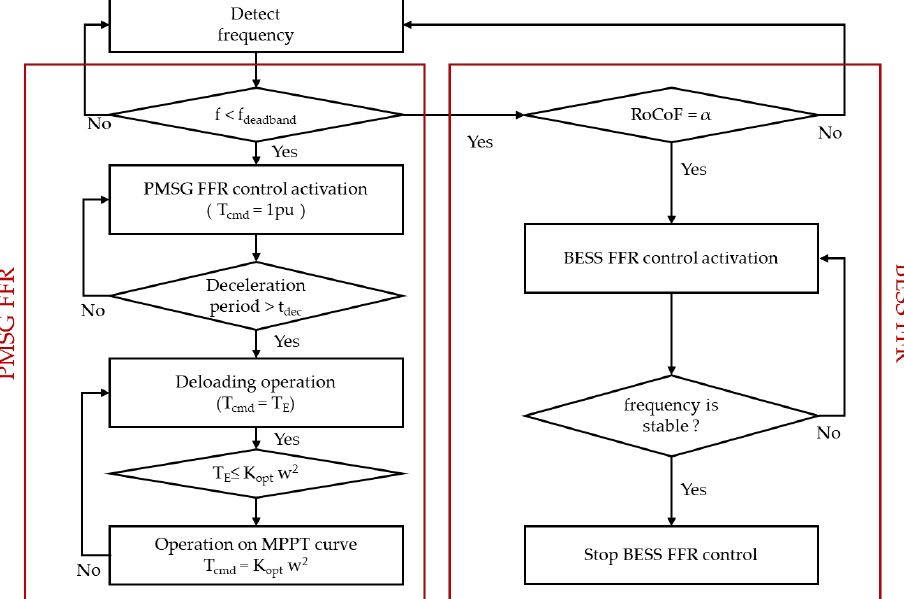
Figure 7. Flowchart of the proposed